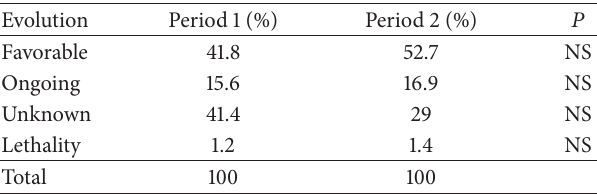
Table 5: Comparison of cases evolution before and after integration of PV-MTCP.